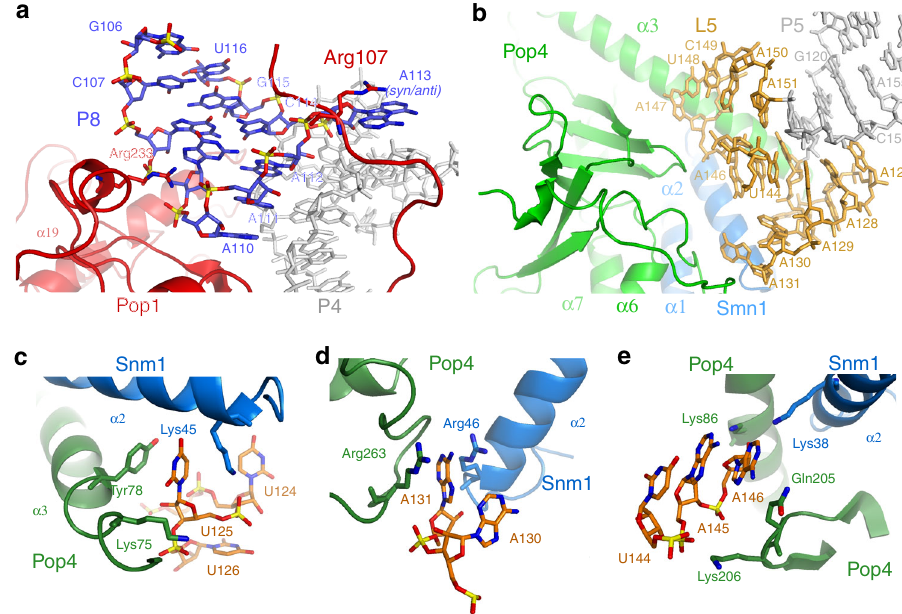
Fig. 3 RNA-protein interactions in RNase MRP. a The structure of the conserved element 5 ′ -GA(G/A)A(G/A)-3 ′ (nucleotides 109 – 113) and its interactions with protein Pop1 (red). The 5 ′ -GA(G/A)A(G/A)-3 ′ element folds into a GNRA tetraloop capping stem P8, with the last purine (A113) bulging out. A113 is observed in both syn- and anti- conformations; the syn- conformation appears to be stabilized by a stacking interaction with the conserved Arg107 of protein Pop1. b – e Loop L5 of the S-domain caps the P5 stem. The loop is devoid of the base pairs; its structure is stabilized by interactions with protein components Pop4 (green) and Snm1